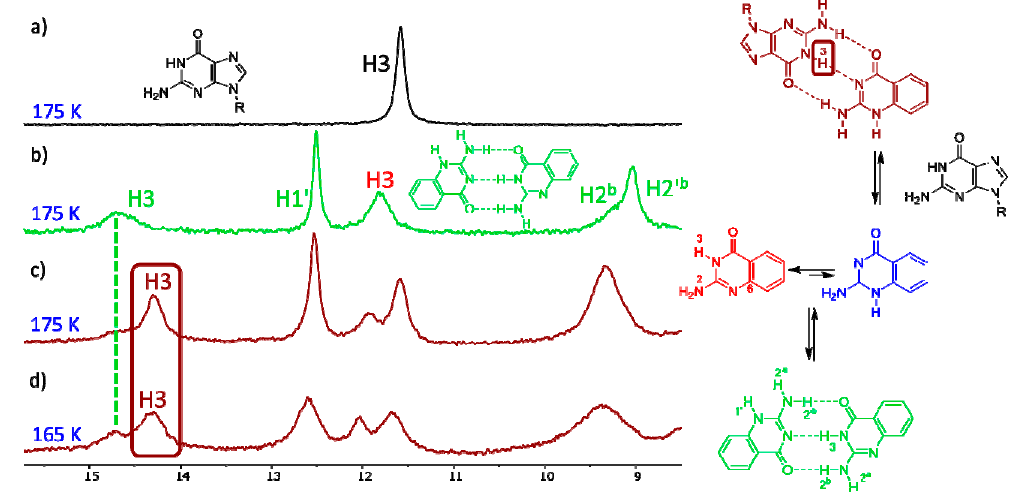
Figure 4. The low-field region of the 1 H - NMR spectra of compound 18 ( a ), compound 16 ( b ) and their 1:1 mixture ( c , d ). 1:1 mixture ( c , d